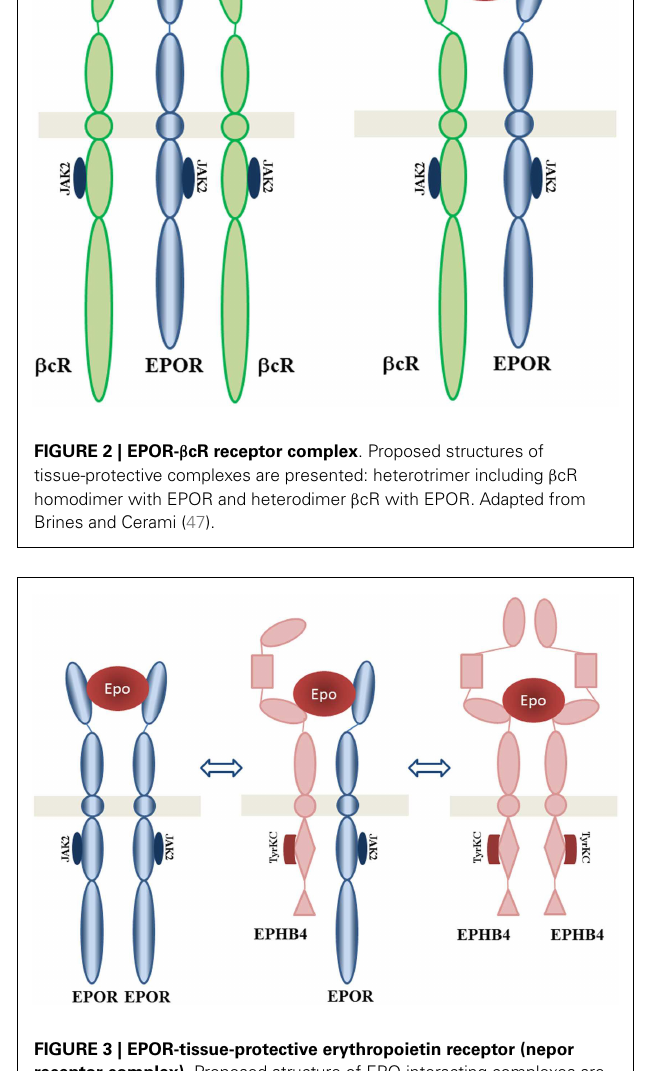
FIGURE 3 | EPOR-tissue-protective erythropoietin receptor (nepor receptor complex) . Proposed structure of EPO interacting complexes are presented: homodimer EPHB4, homodimer EPOR, and heterodimer EPHB4 with EPOR. Adapted from Jackson